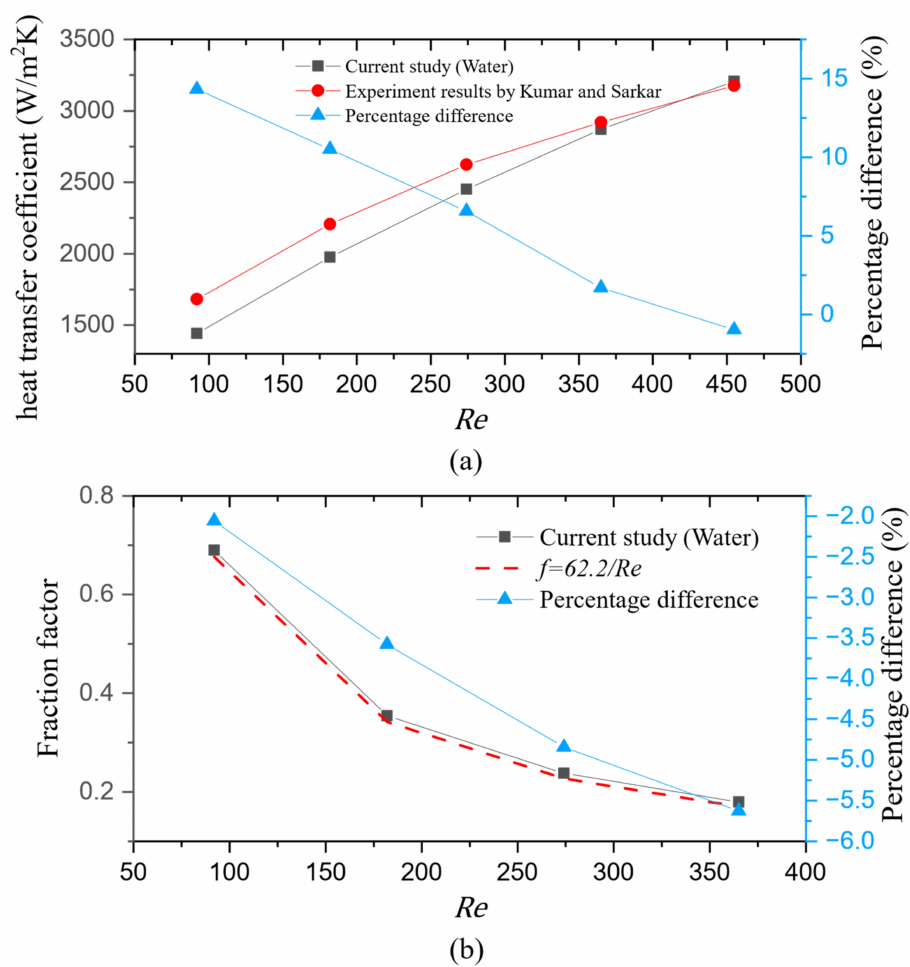
Figure 7. Validation of numerical results ( a ) the average heat transfer coefficient and ( b ) friction